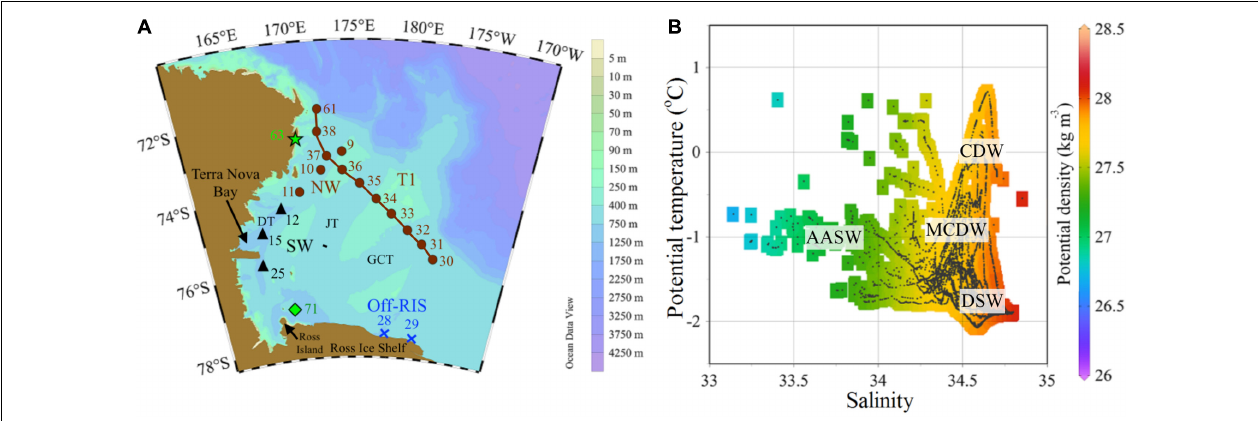
FIGURE 1 | Study area. (A) The Ross Sea study area north of the Ross Ice Shelf (RIS) and east of Victoria Land showing sampling locations with stations labeled as: T1 (sts 30 to 38), northwest – NW (sts 9, 10, and 11), southwest – SW (sts 12, 15, and 25), north of Ross Ice Shelf – off-RIS (sts 28 and 29) and north of Ross Island (st 71). TNB–Terra Nova Bay; bathymetry shows the banks and three main troughs: Drygalski (DT), Joides (JT) and Glomar Challenger (GCT) Troughs. (B) Potential temperature–salinity diagram with isopycnals ( σ θ ) obtained from CTD profiles at the sampling stations. Water masses CDW, MCDW, AASW and DSW as defined by Jacobs et al. (1985) and Orsi and Wiederwohl